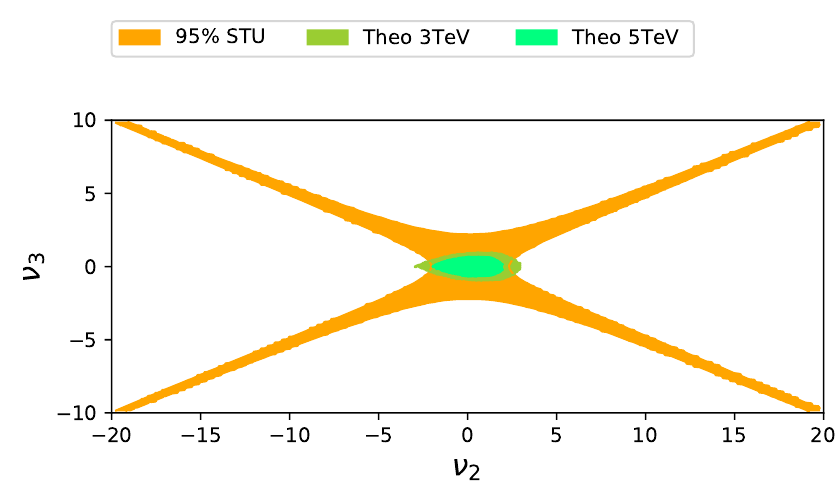
Figure 3 . Allowed two-dimensional regions of ν 2 and ν 3 from the oblique parameters (orange, 95% probability) and from theoretical constraints (green) with the NLO+ approximation. The darker and lighter green areas correspond to requiring RG stability up to 3 and 5 TeV,